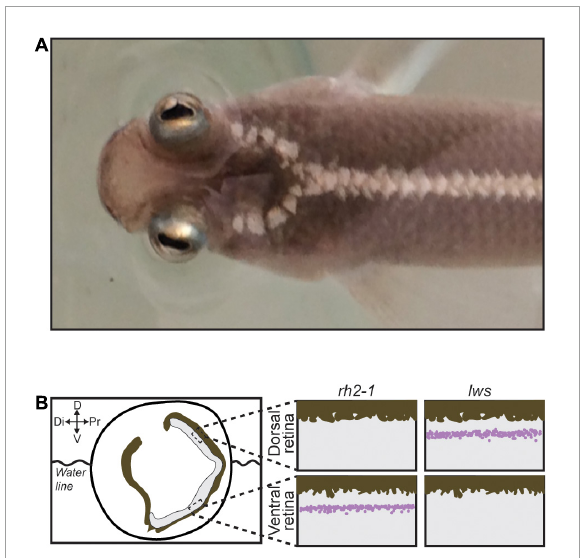
FIGURE1 The Anableps anableps. (A) Anableps anableps female specimen, dorsal close-up view of the A. anableps head and part of the body. (B) Schematic of the A. anableps eye showing the water line and asymmetric gene expression of lws and rh2-1 genes in the dorsal and ventral retinas, respectively. Dorsal (D), Di ( Distal), V (Ventral), and Pr